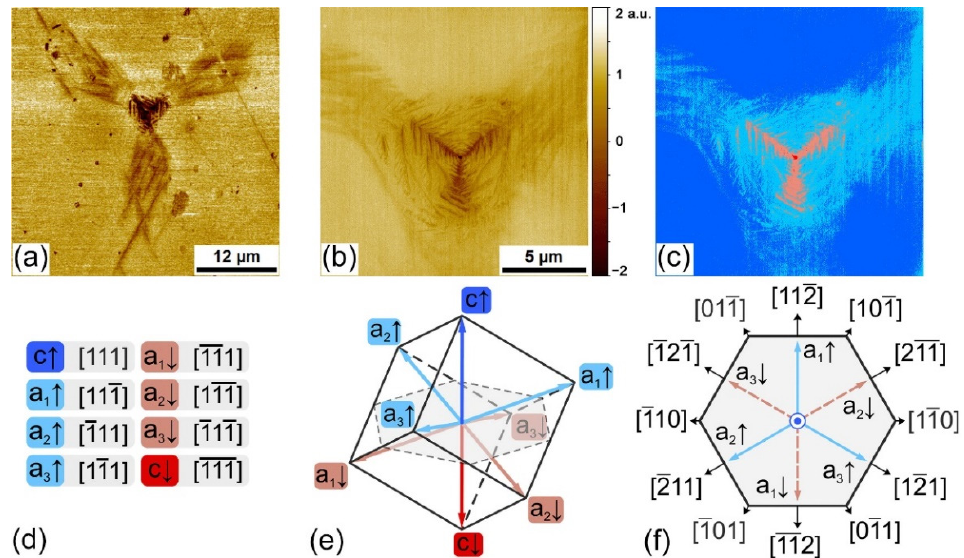
Figure 1. Local switching by 90 V, with a 500 ms voltage pulse in the dry atmosphere. The PFM images of different domain structures: ( a ) full-scale image and ( b ) central region. ( c ) Schematic illustrating orientation of the polarization of image ( b ). ( d , e ) Polarization notation and orientation used in the schematic ( c ). ( f ) Characteristic directions at (111) plane for an [111] oriented rhombohedral